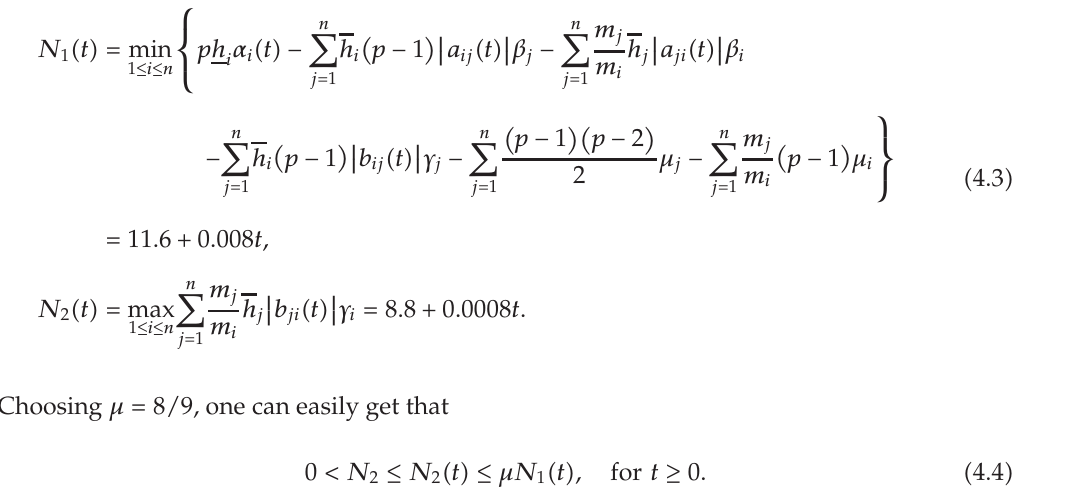
(cid:6) t (cid:7)(cid:7) of system (cid:6) 4.1 (cid:7) 1